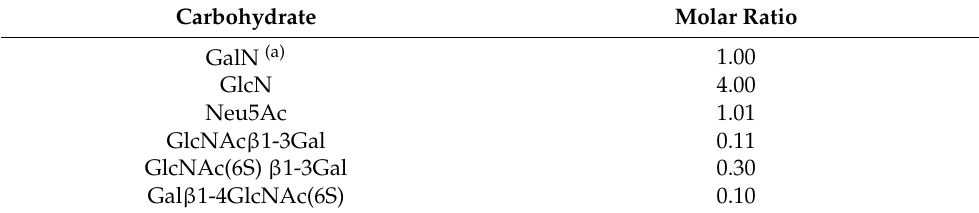
Table 1. Chemical analysis of R-10G-binding protein from 201B7